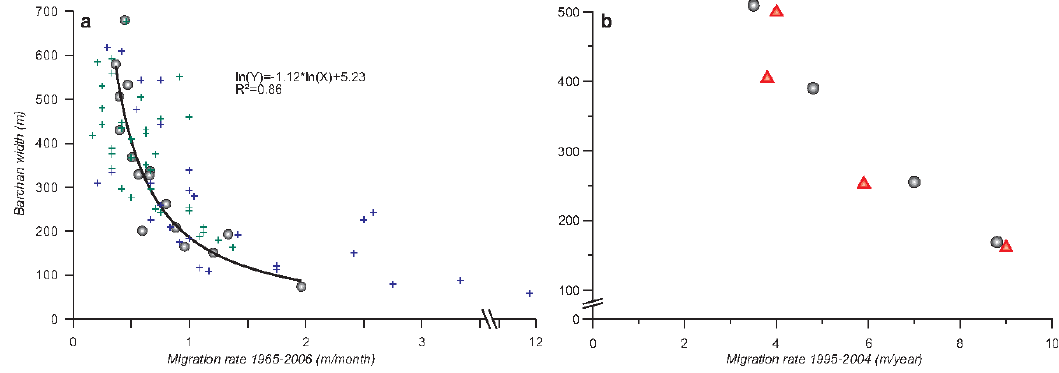
Figure 6. ( a ) Relationship between size of barchan dunes B1–B16 and migration rate over the time period 1965–2006 (circles), which is best explained by an inverse power ‐ law function ( R 2 = 0.86). For comparison, results of Embabi and Ashour [10] derived for Umm Said sabkha (1971–1976; blue crosses) and Nigyan Abu ‐ Qatabatin (1973–1976; green crosses) are plotted. Heights given in the original source [10] were translated into horn ‐ to ‐ horn width using Equation (2); ( b ) Comparison of migration rates between pairs of similarly sized dunes migrating over dry Dammam limestone surface (circles) and moist sabkha surface